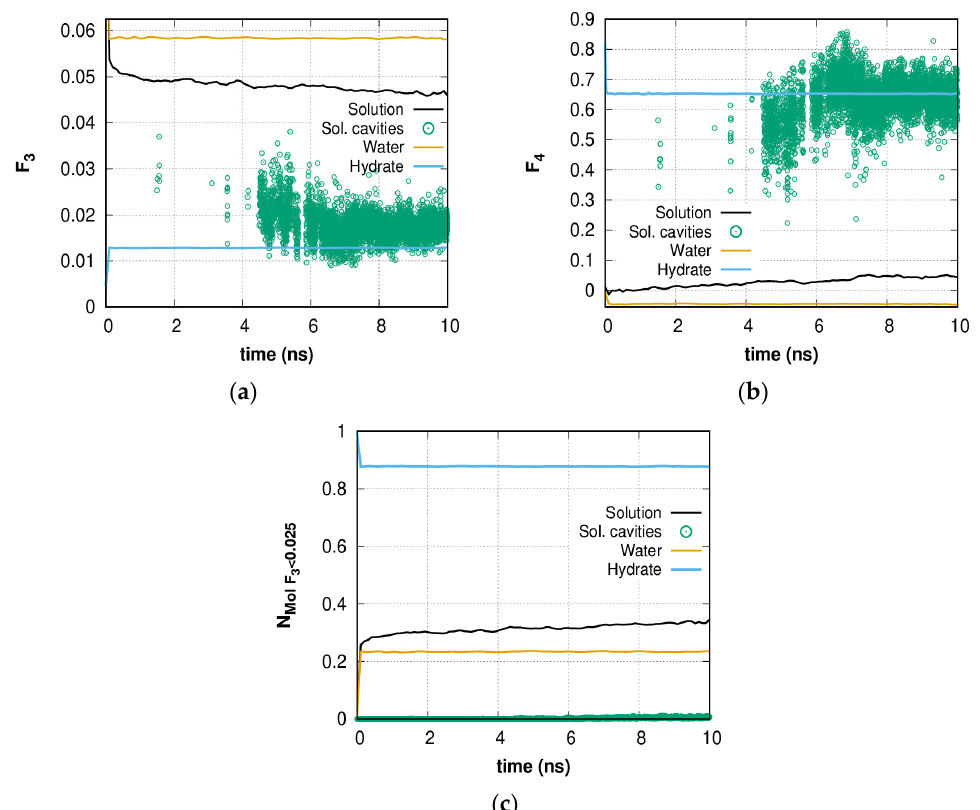
Figure 2. Time dependence of ( a ) F 3 and ( b ) F 4 order parameters of 0.6 H 2 O + CH 4 solution ( black line ), pure water ( orange line ), and bulk hydrate ( blue line ) phases (time period corresponding to 0–1 ns and stretched to 0–10 ns for comparison). The green open circles represent the corresponding data for cavity-forming molecules. The data are smoothed; ( c ) Time dependence of the portion of all molecules having molecular parameter F 3 < 0.025 in 0.6 methane solution, bulk hydrate, and pure water. The data are smoothed.